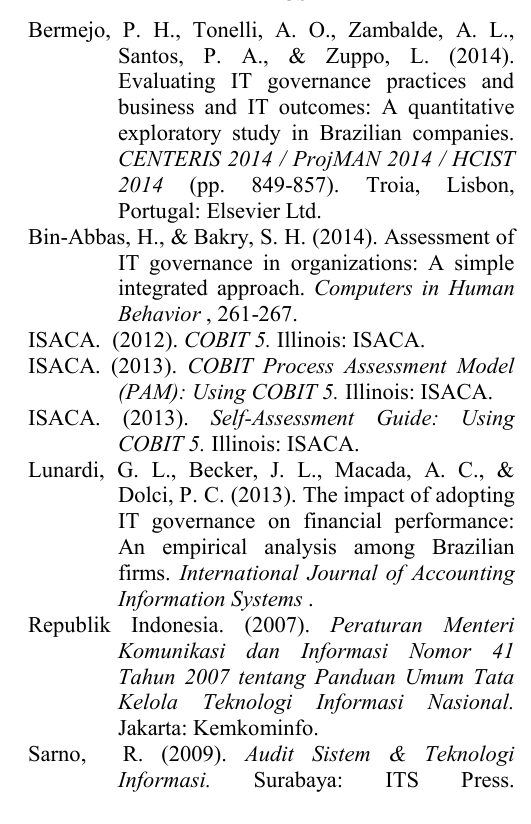
Align, Plan, and Organize